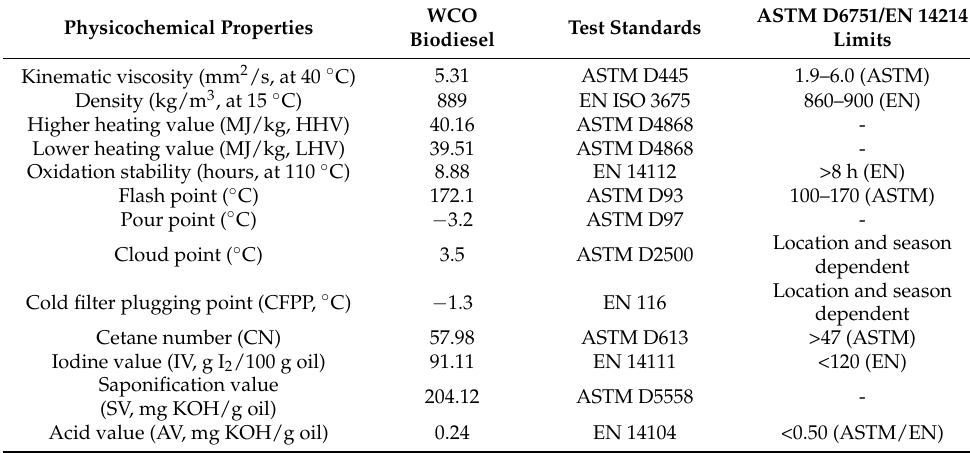
Table 5. Physicochemical properties of the WCO biodiesel.